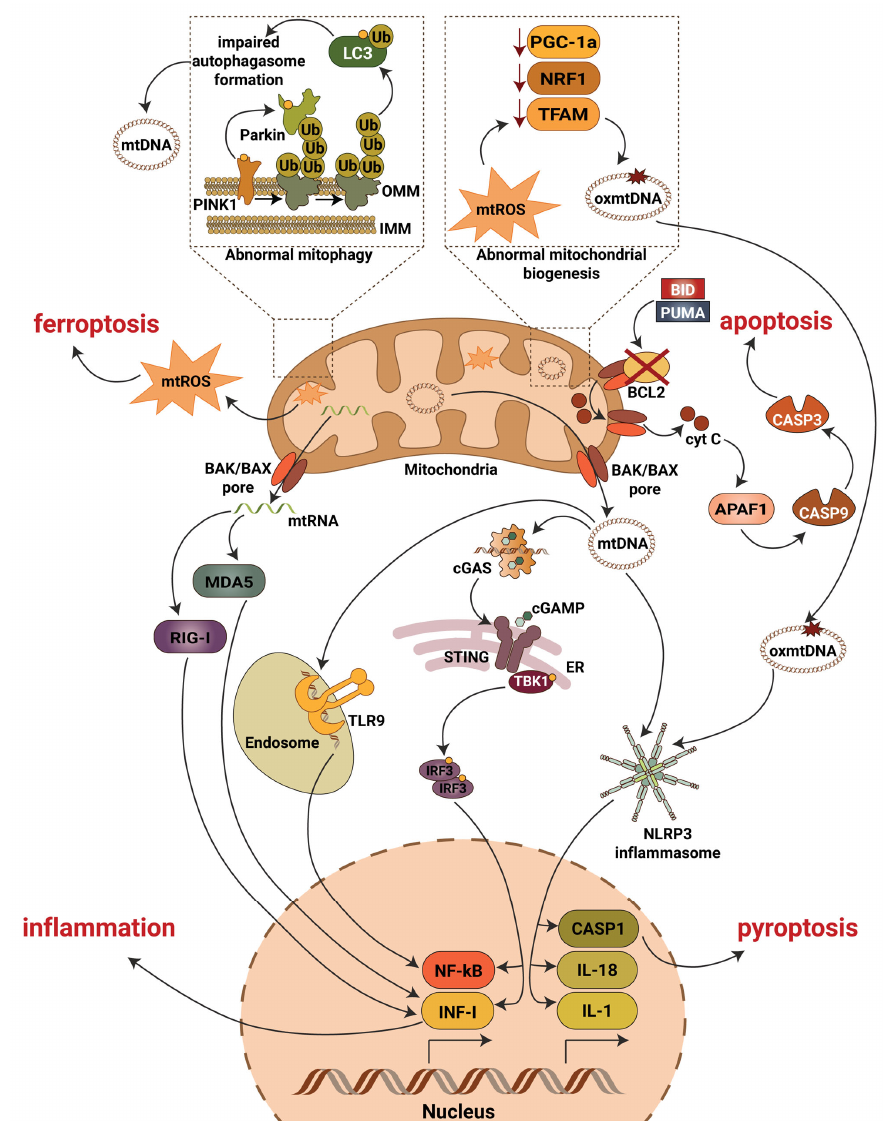
Figure 2. Mitochondrial contribution to DKD associated kidney damage. Generation of mitochon ‐ drial reactive oxygen species (mtROS), escape of mitochondrial RNA (mtRNA) and mitochondrial DNA (mtDNA) into cytosol, production of oxidized mitochondrial DNA (oxmtDNA) and abnor ‐ malities in mitophagy lead to activation of major pro ‐ inflammatory signaling pathways, pyroptotic, apoptotic and ferroptotic cell death. Abbreviations: APAF1—apoptotic pepdidase activating factor